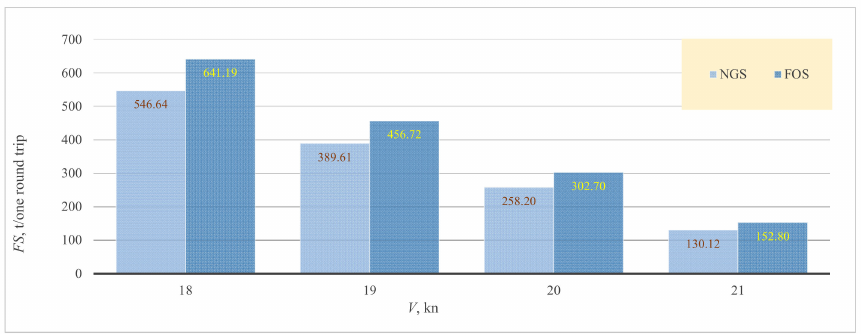
Figure 22. The fuel savings per one trip for navigation under MWC.